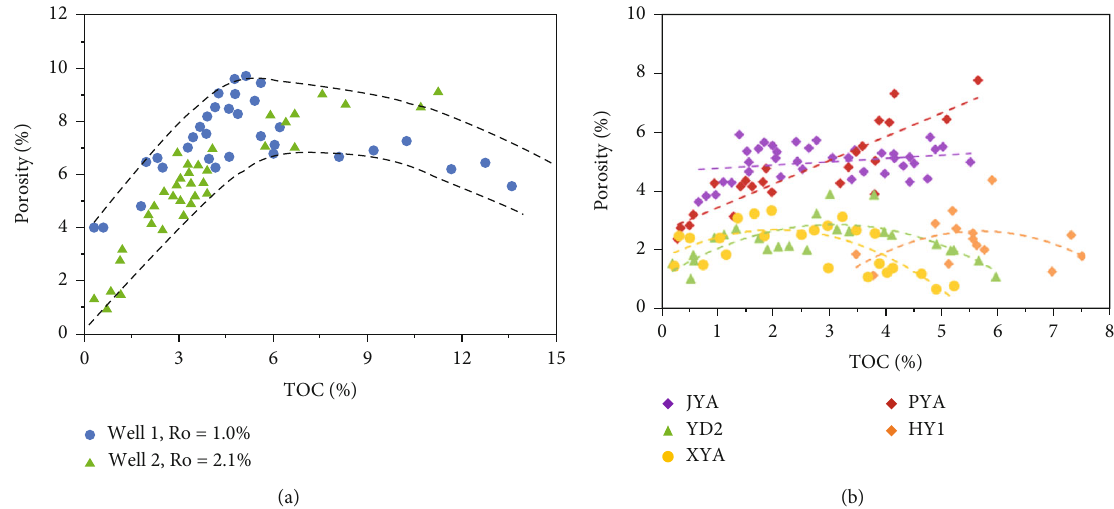
Figure 9: Cross-plots of the TOC value versus porosity of (a) the Marcellus shales in North America and (b) the Lower Paleozoic shales in South China. ((a) modi fi ed from Milliken et al.[37]; (b) data from Xiong, [119]; Xu et al., [153]; Chen et al., [175]).